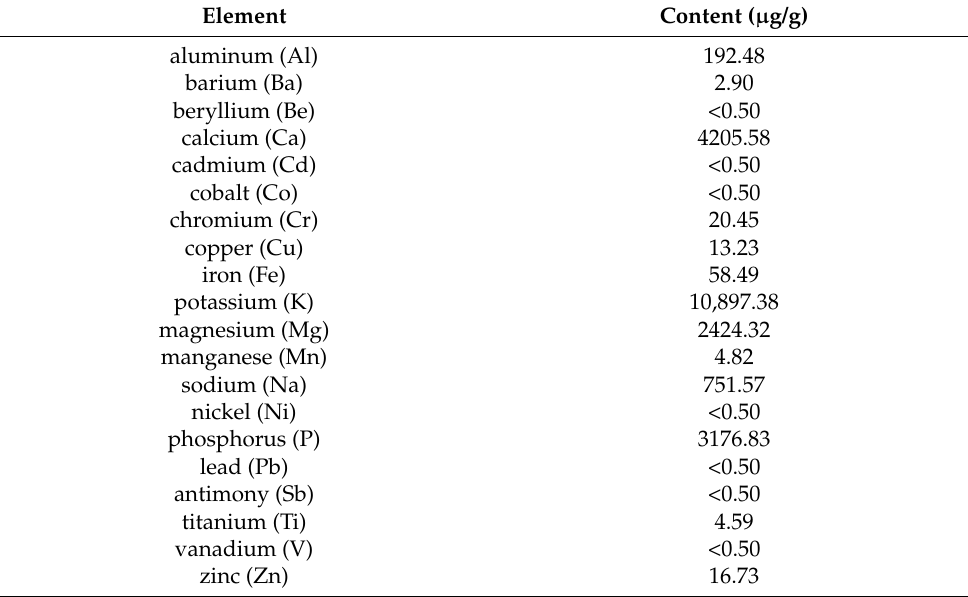
Table 4. Elements in burdock root powder from